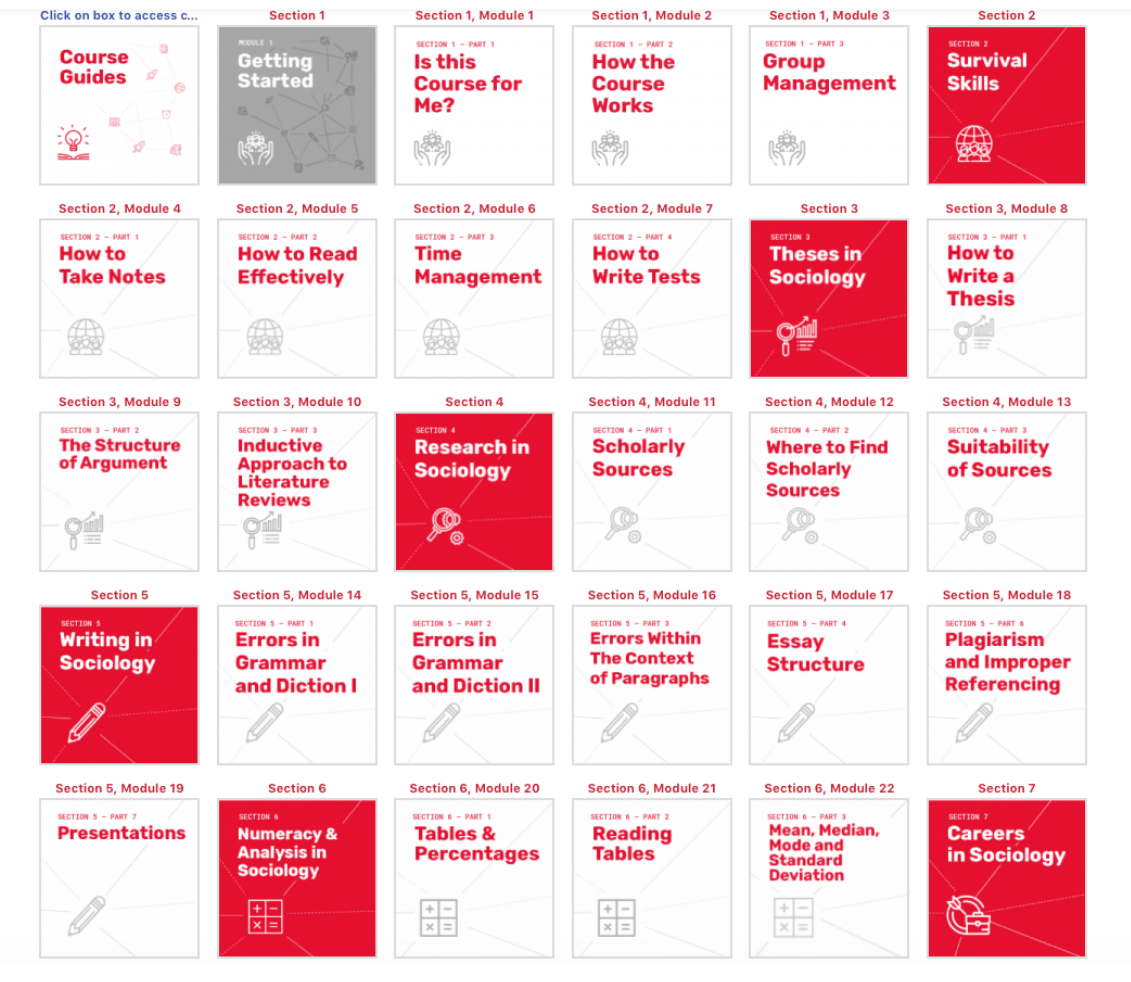
FIGURE 2. AREAS OF SKILL